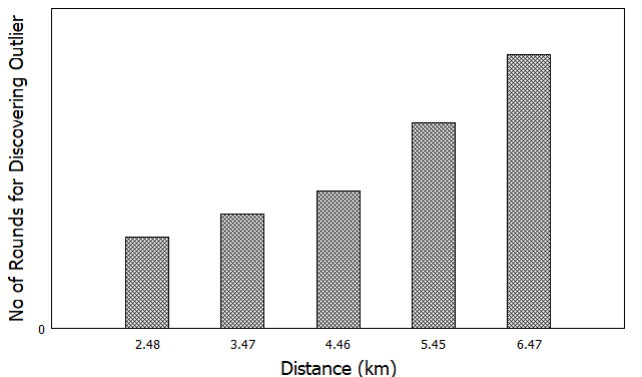
Figure 11. Effects of varying distances between S-D on the number of rounds to discovered outliers’ trajectories.